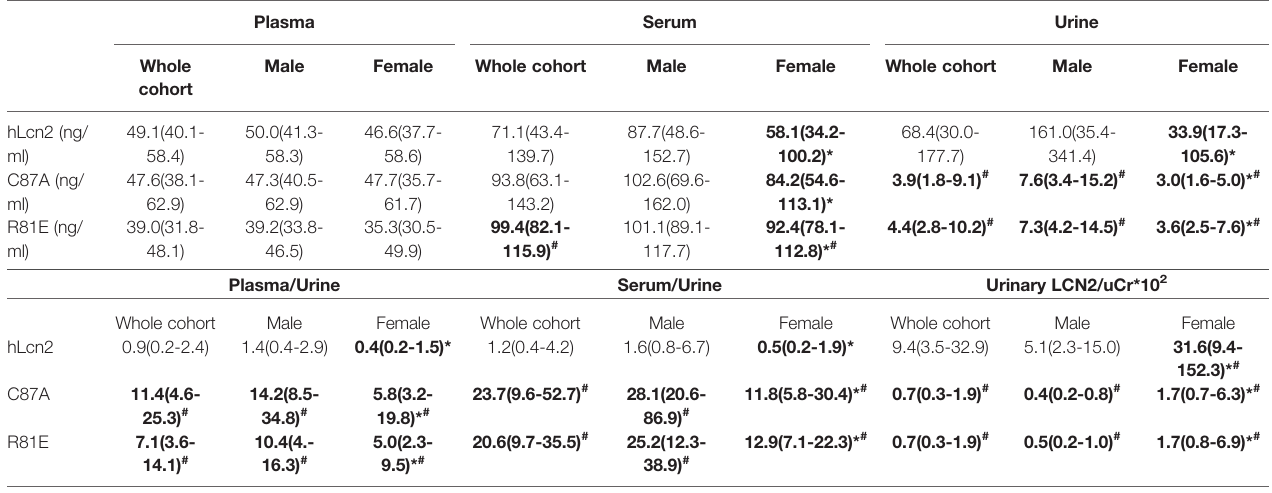
TABLE 2 | Concentrations of LCN2 variants in samples from healthy cohort a . Plasma Serum